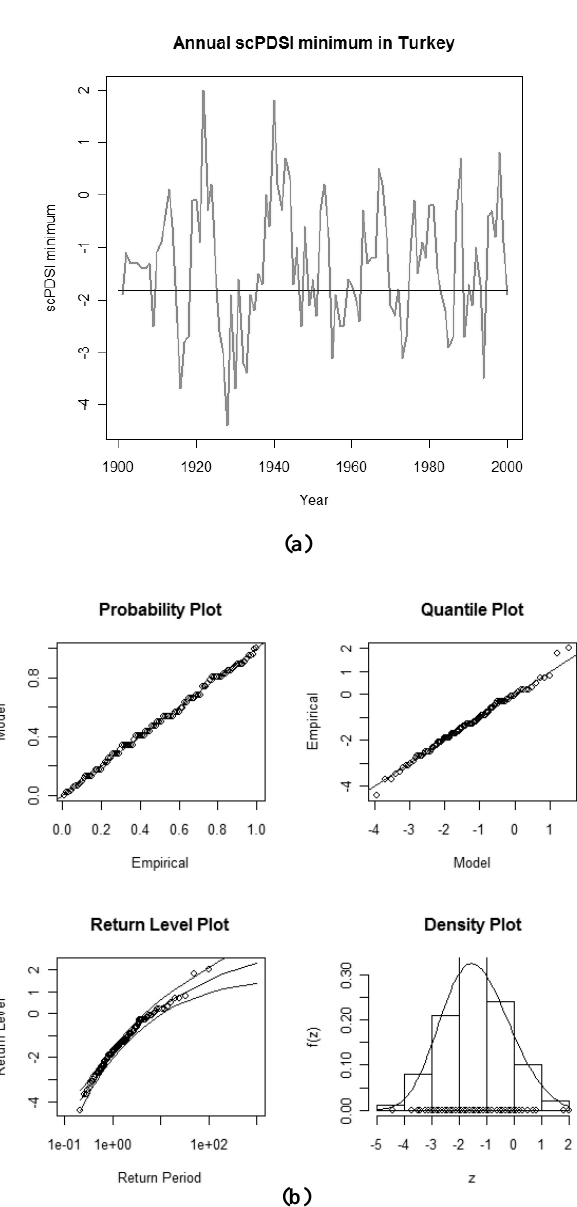
Fig. 9. (a) Annual scPDSI minimum in Turkey; (b) diagnostic plots for GEV fit to the Turkey minimum scPDSI